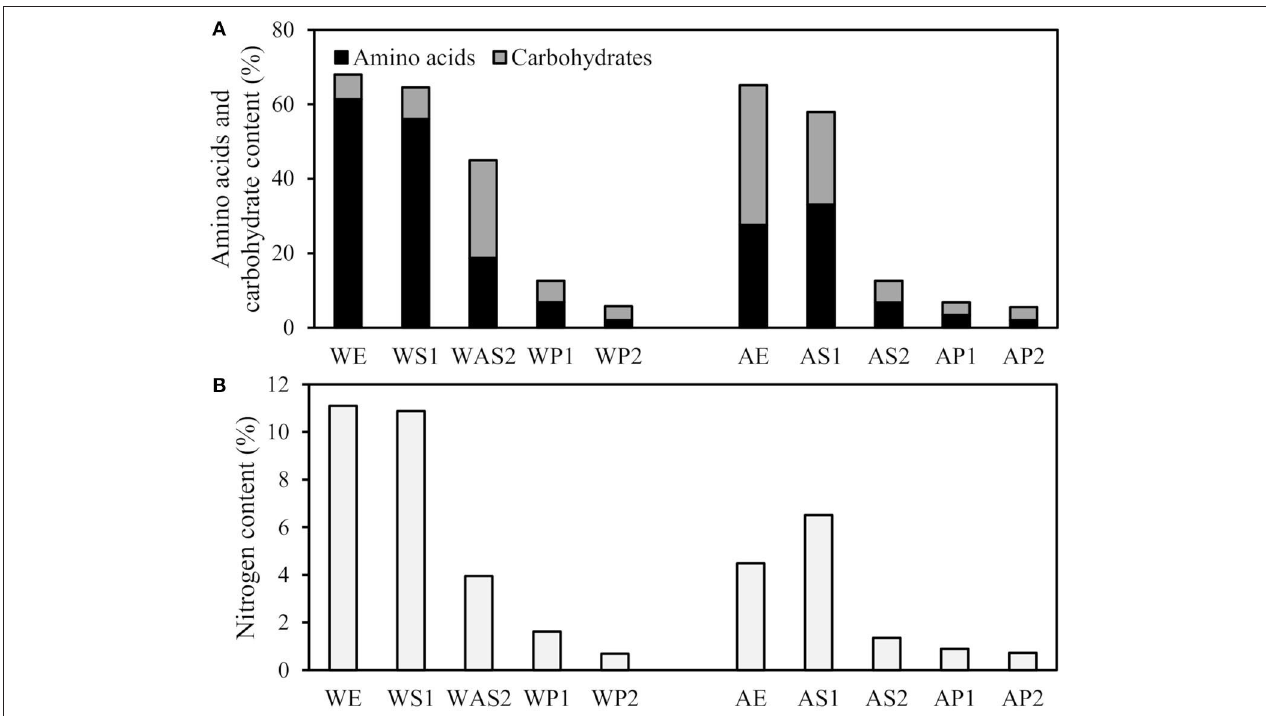
FIGURE 3 | (A) Total carbohydrate and amino acid content (w-% from dry weight), and (B) nitrogen content (w-% from dry weight) of fractions extracted from biomass. Please refer to Figure 1 for the fraction codes.